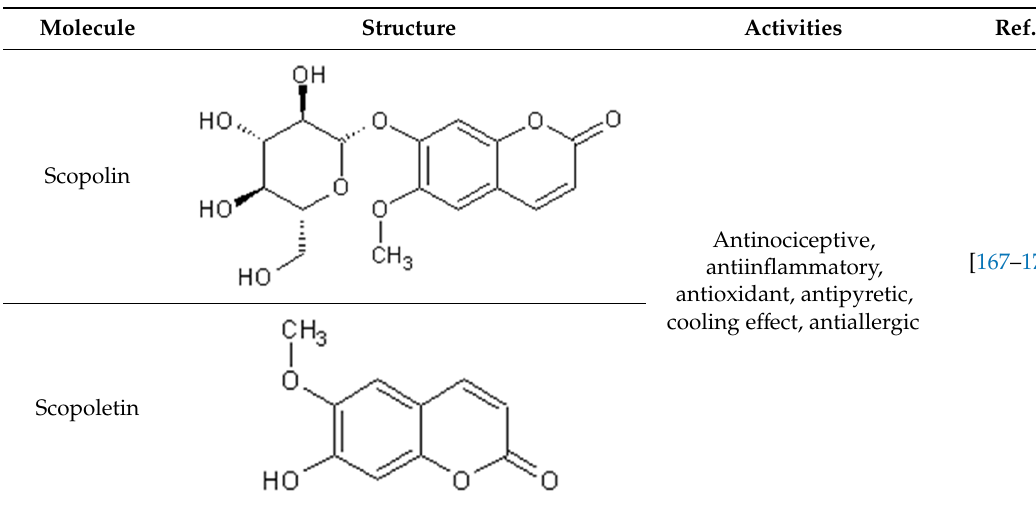
Table 4. Structure and biological activities of major coumarins of Artemisia annua .